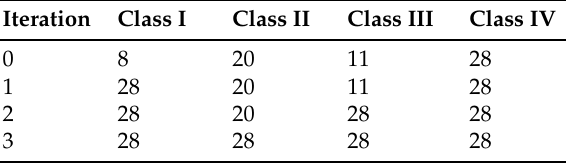
Table 8. South Korea—Random Over-sampling of data